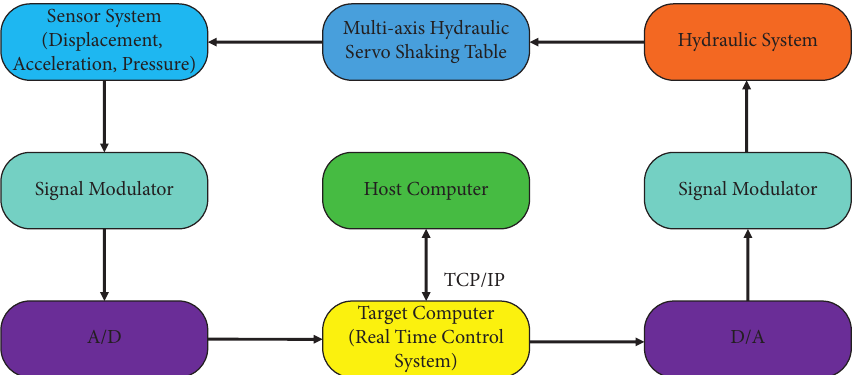
Figure 2: Schematic diagram of the multiaxis hydraulic servo shaking table.